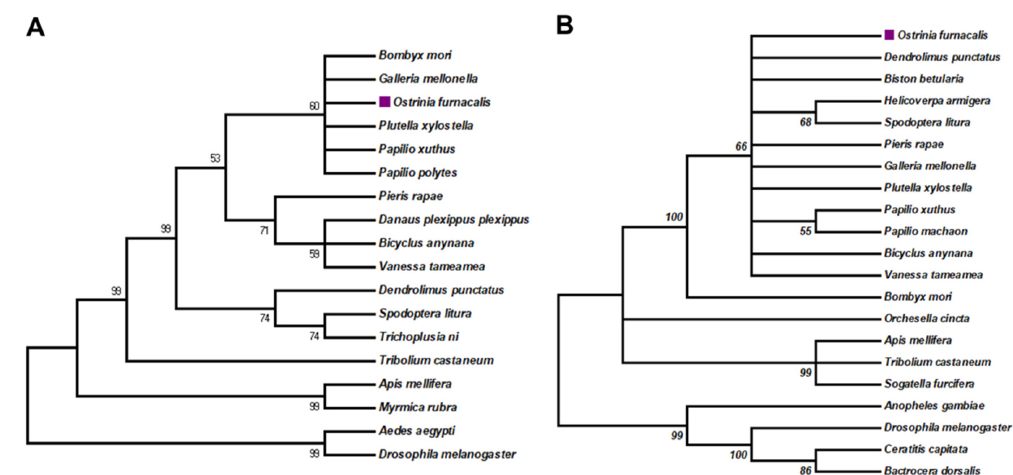
Figure 1. Phylogenetic analysis of OfAbd-A and OfUbx genes. The evolutionary histories of Abd-A and Ubx were inferred using the neighbor-joining method. The percentages of replicate trees in which the associated taxa clustered together in the bootstrap test (1000 replicates) are shown next to the branches. Evolutionary distances were computed using the Poisson correction method and are listed as the number of amino acid substitutions per site. ( A ) The phylogenetic analysis of Abd-A involved 18 amino acid sequences. OfAbd-A was denoted by a square. ( B ) The phylogenetic analysis of Ubx involved 21 amino acid sequences. OfUbx was denoted by a square.